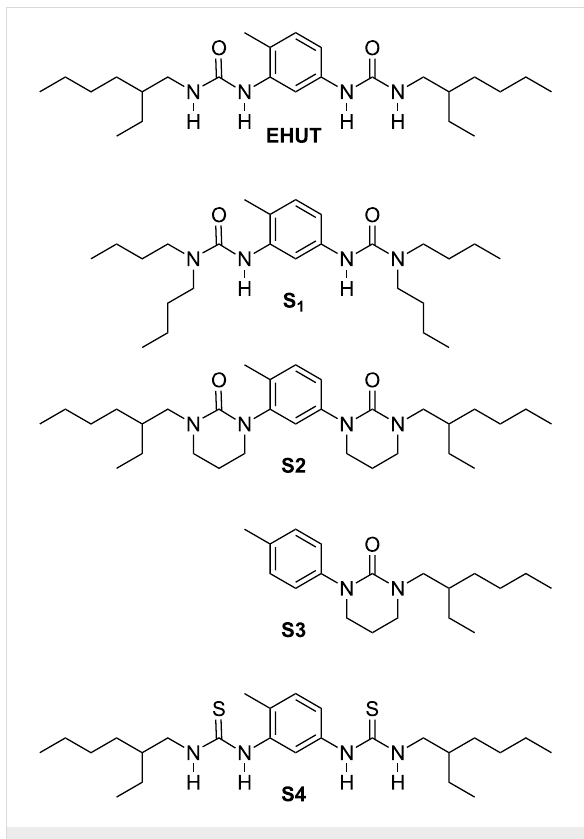
Figure 1: Structures of monomer EHUT and chain